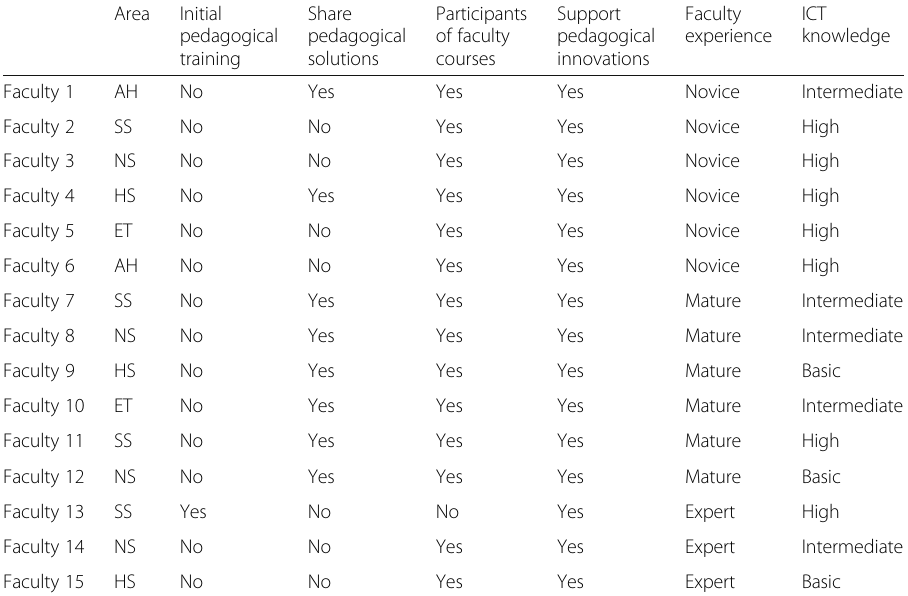
Table 2 The Backgrounds of the Faculty